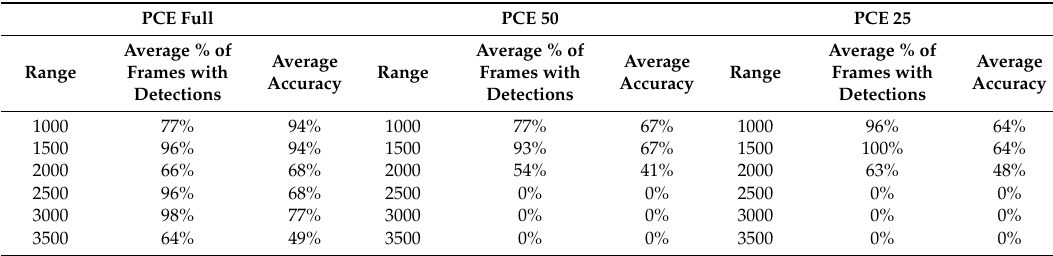
Table 10. Averaged classification results at PCE full, PCE 50, and PCE 25 for the MWIR nighttime videos. 1500 m and 3000 m were used for